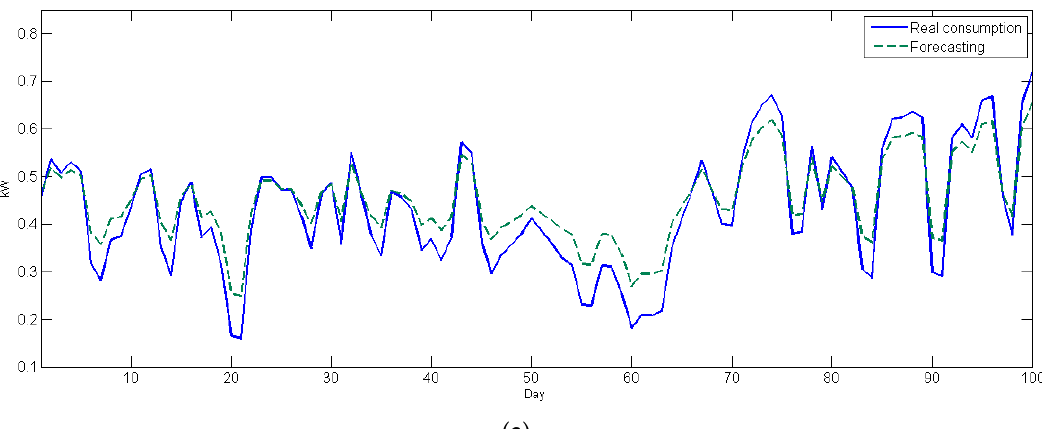
Table 4. MSE of the neurons parameter obtained with the NARX model.